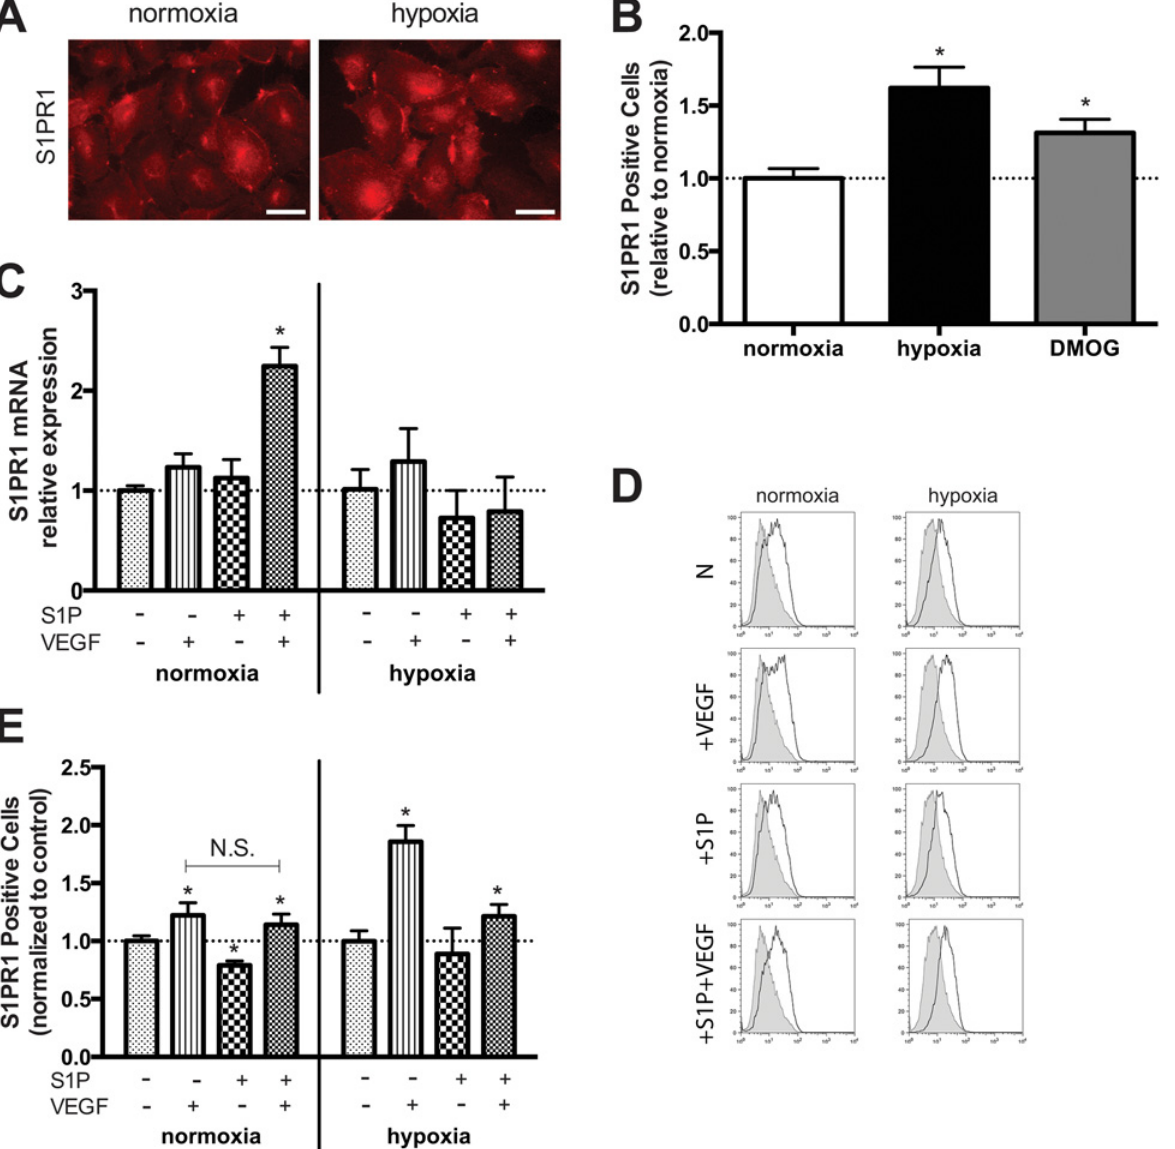
Fig 1. S1PR1 expression by OECs is dynamically altered by microenvironment. OEC expression of S1PR1 under normoxia and hypoxia was qualitatively confirmed by immunocytochemistry (A). The percentage of cells expressing S1PR1 on the cell surface, as confirmed with flow cytometry, was enhanced under hypoxia as compared to the normoxic control (B). Combined stimuli of S1P and VEGF resulted in greater S1PR1 mRNA production after 24h in normoxia (C). Combined stimuli also resulted in a greater proportion of S1PR1+ OECs under both normoxia and hypoxia (D and E). Scale bars represent 40 μ m. Data are mean ± SD (n = 4) and normalized to the average untreated control values for either normoxia or hypoxia (C, E; indicated by dashed line) accordingly. An asterisk indicates statistically significant differences (P < 0.05) between conditions in normoxia or hypoxia respectively and N.S. displays no statistically significant difference between